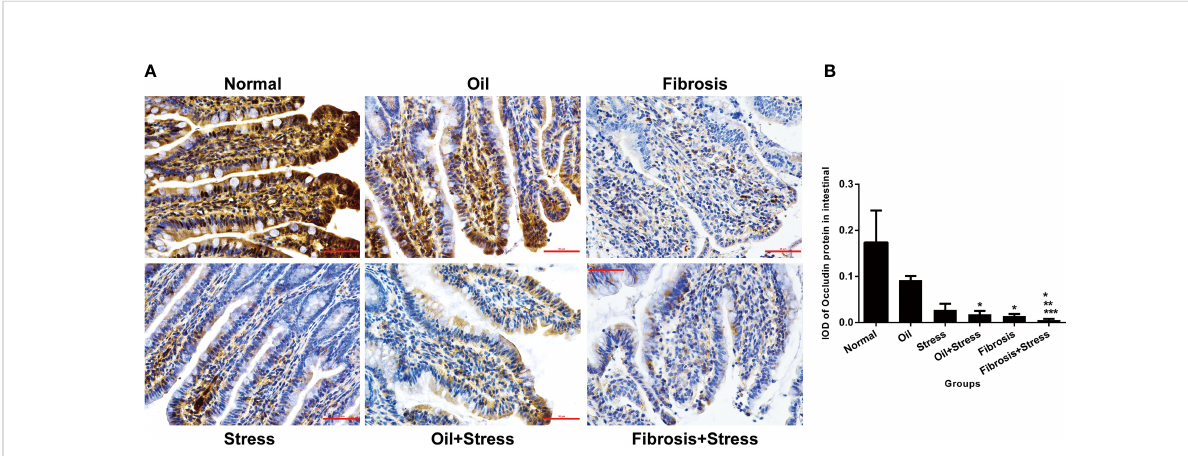
FIGURE 4 Occludin protein expression in intestinal tissue of rats. (A) Immunohistochemical staining of occludin protein in intestinal tissue. Scale bar: 50um. (B) Semi-quantitative analysis of occludin protein in intestinal tissue. Data are shown as means ± SD. * p < 0.05 vs. normal group and oil groups; ** p < 0.01 vs. stress group and oil+stress groups; *** p < 0.001 vs. fi brosis